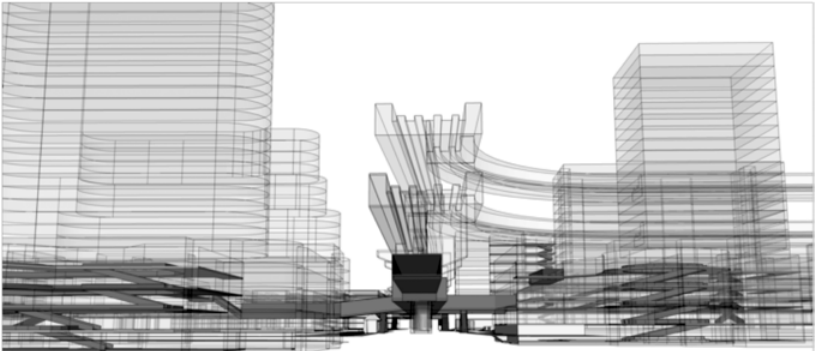
Figure 2. Still from mobile section through Bangkok’s Central Shopping